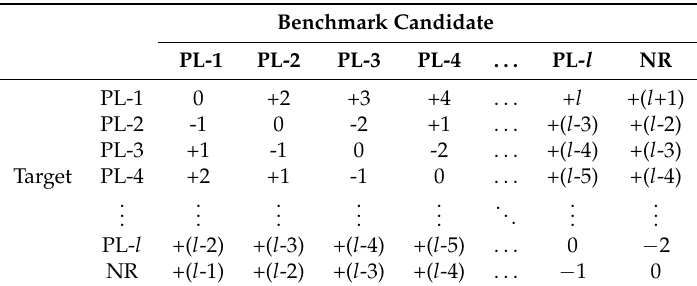
Table 1. The priority conversion rule.